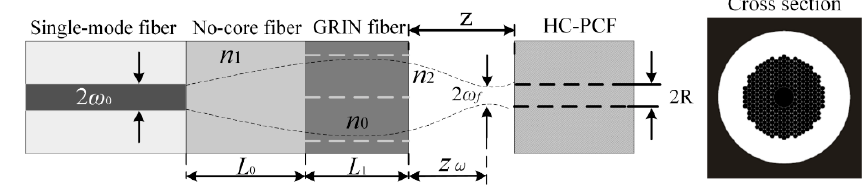
Figure 1. Coupling model of the GRIN fiber probe and HC-PCF.